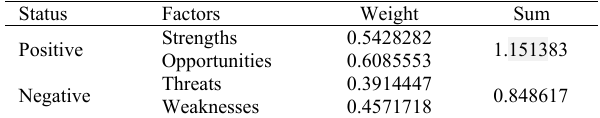
Table 5: IFEM and EFEM Results with positive and negative approach